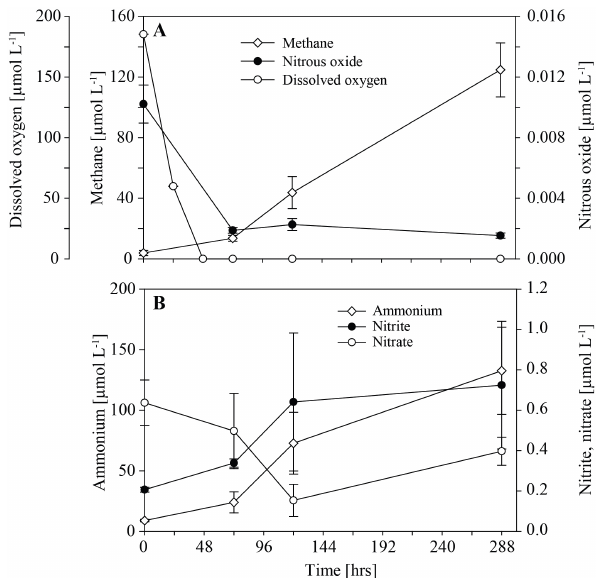
Figure 5. Sediment incubations of the shallow site s4: dissolved oxygen, methane, nitrous oxide (a) and nutrient production or con- sumption (b) . Values represent averages ± SE, n =